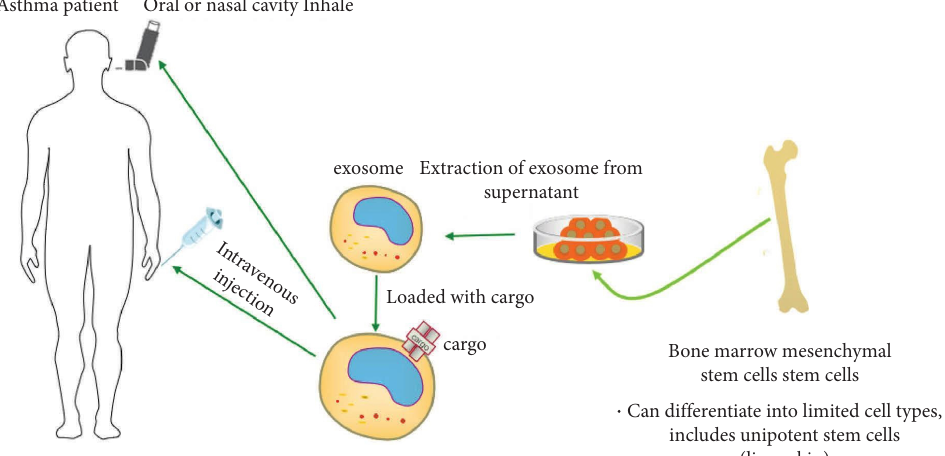
Figure 2: Purifed exosomes which are derived from bone marrow mesenchymal stem cells, express various functions in treating asthma. Intravenous or inhalation administration both seem feasible methods for delivering exosomes, and the cargo carried by the exosomes could have important efects in